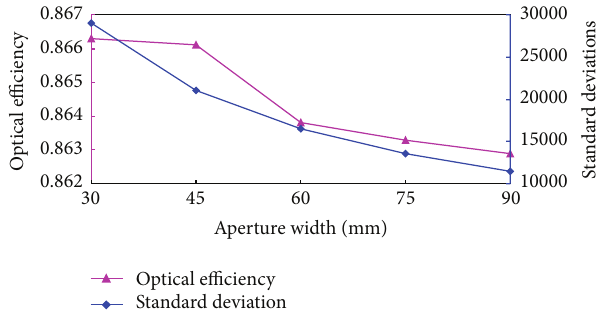
Figure 5: The optical properties of cavity at different aperture width.